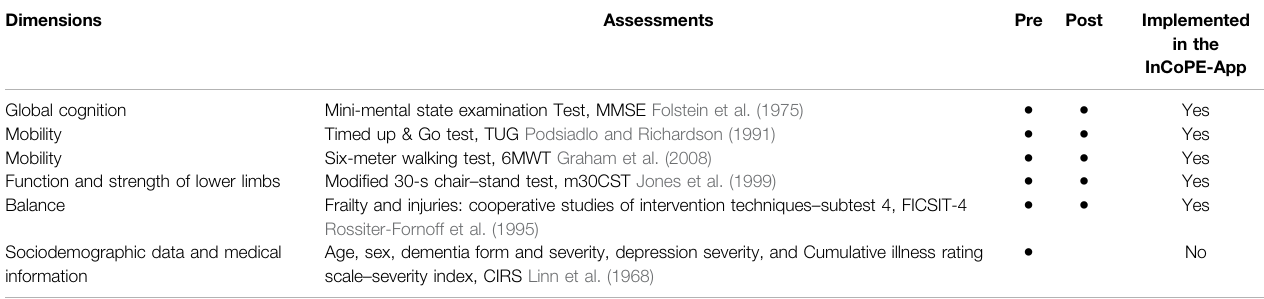
TABLE 2 | Secondary outcomes for the effectiveness of the InCoPE-App.